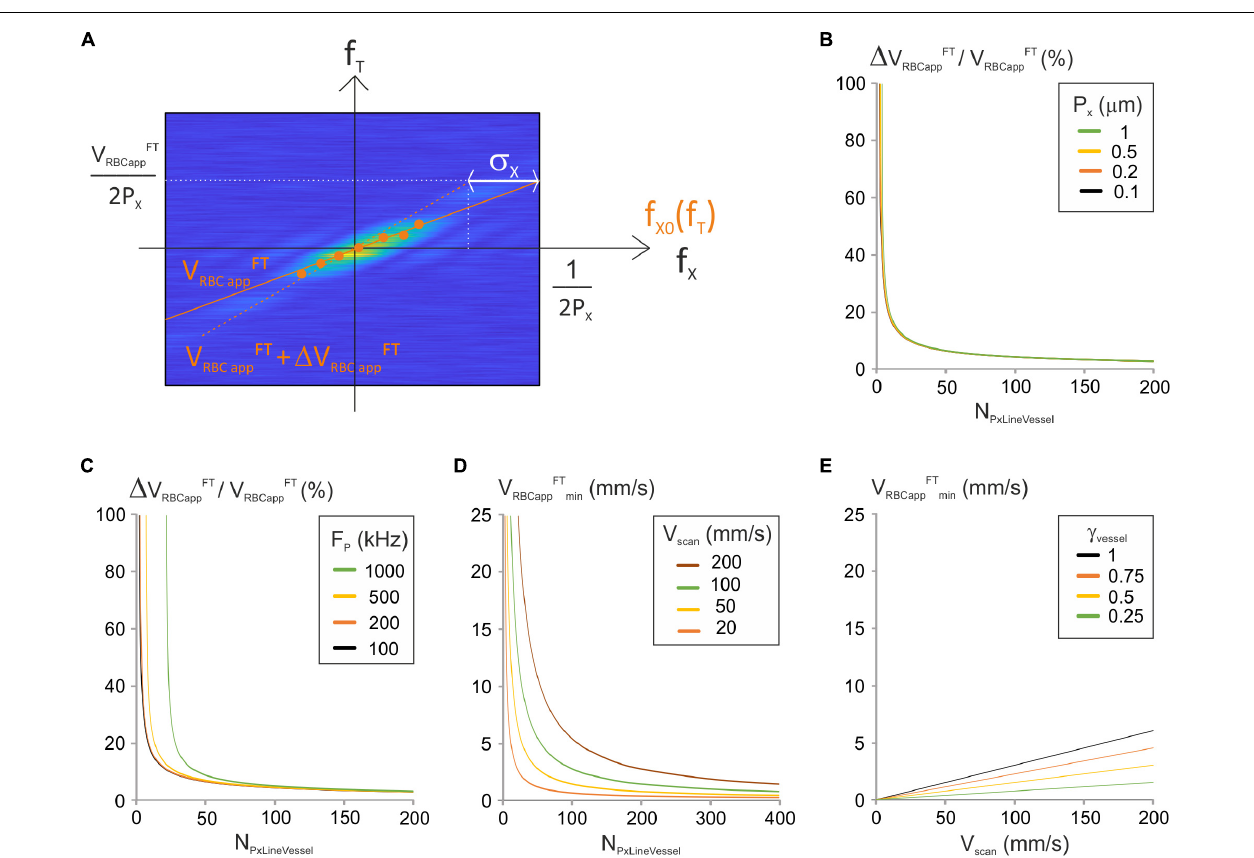
FIGURE 3 | Analysis of the “Fourier-transform” image-analysis method. (A) Principle of the “Fourier Transform” image-processing algorithm: modulus of a Fourier-transformed spatiotemporal image (magnified for the purpose of clarity) with time frequencies (f T ), spatial frequencies (f x ), maximal spatial frequency F xmax = 1/(2P x ), expectancy of the spatial frequencies f x0 (f Ti ) for some temporal frequencies (f Ti ) (orange dots) and standard deviation of the spatial frequencies ( σ x ). The relation between f x0 (f Ti ) and f Ti is fit by a first order polynomial whose first order coefficient is V RBCapp FT (orange full line). Its upper point was shifted by σ x to get V RBC appFT + (cid:49) V RBC appFT (orange dashed line). (B) (cid:49) V RBC appFT / V RBC appFT was calculated vs. N PxLineVessel from Equation (18) for a range of P x with F p = 200 kHz and J/(f τ ) = 2 10 − 8 s 2 /m. (C) (cid:49) V RBC appFT / V RBC appFT was calculated vs. N PxLineVessel from Equation (18) for a range of F p with P x = 0.5 µ m and J/(f τ ) = 2 10 − 8 s 2 /m. (D) V RBC appFT min vs. N PxLineVessel was calculated from Equation (20) for a range of V scan with γ Vessel = 1 and γ Flyback = 0.5. (E) V RBC appFT min vs. V scan was calculated from Equation (20) for a range of γ Vessel with N PxLineVessel = 50 and γ Flyback =